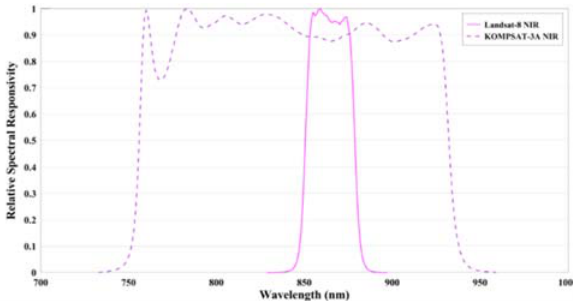
Figure 5. Comparison of the RSR in the